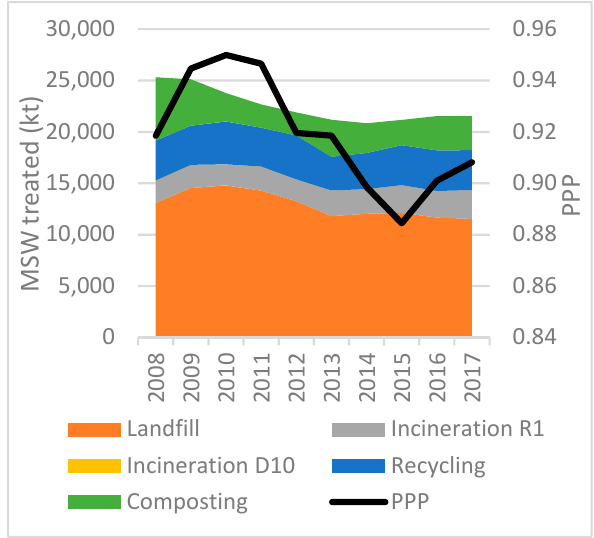
Figure 18. Waste treatment methods and PPP in Spain 2008–2017 (EUROSTAT 2019b, 2019c).